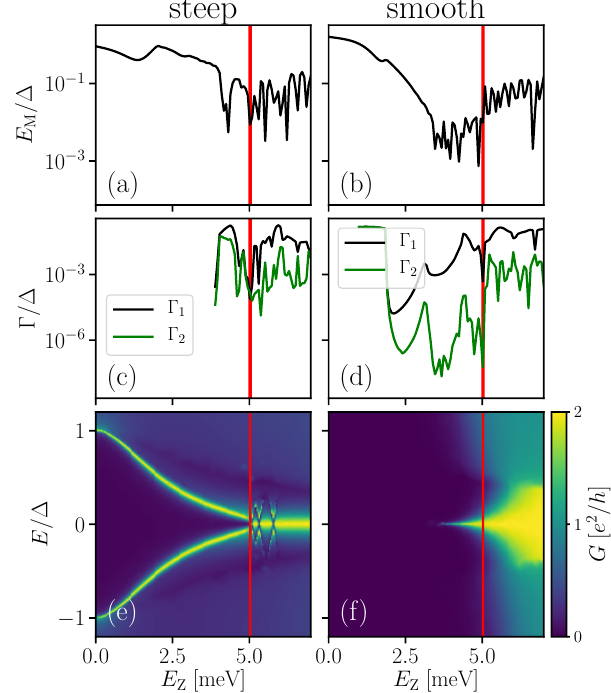
Figure 5: Coupling energy and conductance as a function of Zeeman energy E for Z a steep tunnel barrier ( σ = 10 nm, left column) or for a smooth tunnel barrier ( σ = 100 nm, right column) with quasi-Majorana states. (a, b): Coupling energy between the two lowest states E . (c, d): Coupling energy to the probing lead Γ , Γ M 1 2 of the two lowest states. We do not include the coupling for small Zeeman energies, since the energy of the lowest state is too large compared to the bulk gap in this regime for the approximation of Sec. 2.3 to hold. (e, f): Conductance as a function of bias energy E and Zeeman energy E . In all panels, the red vertical line indicates Z the topological phase transition. The barrier heights and smoothness are V = 18 meV, σ = 10 nm for the left column and V = 11.7 meV, σ = 100 nm for the right column respectively, and the chemical potential is µ = 5 meV for all